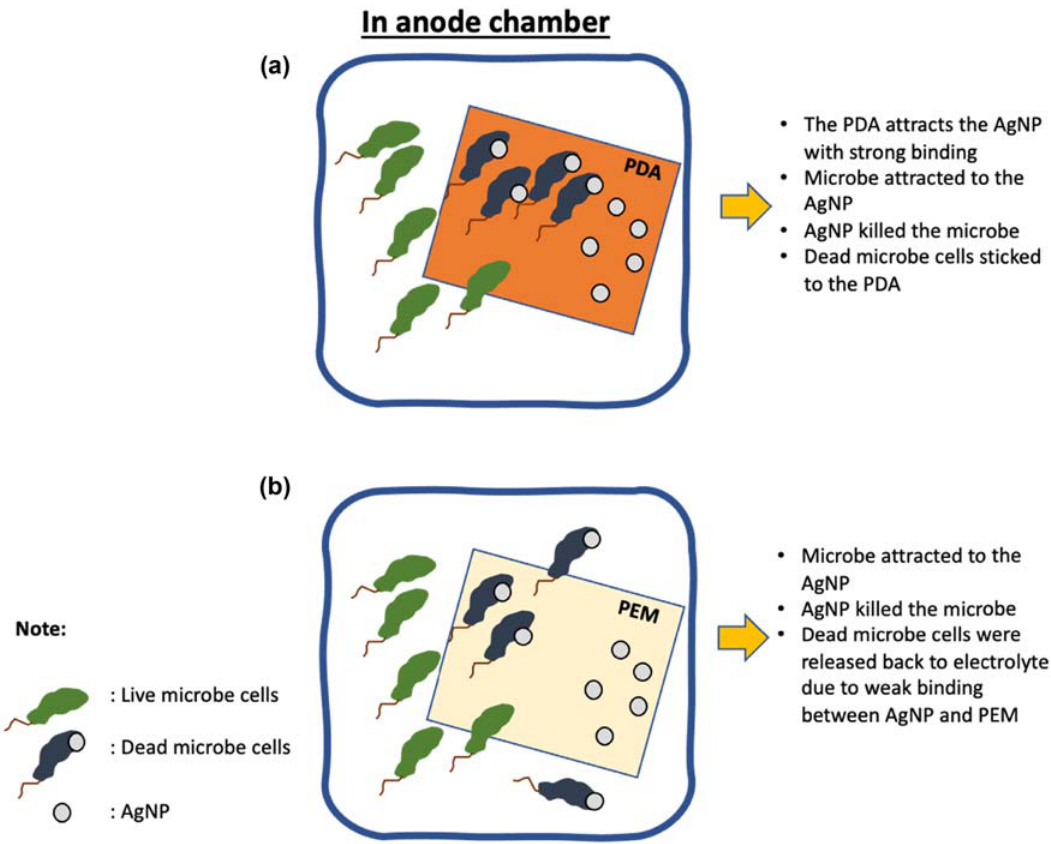
Figure 6: BFC membrane surface modi fi ed with ( a ) AgNP and polydopamine and ( b ) AgNP and